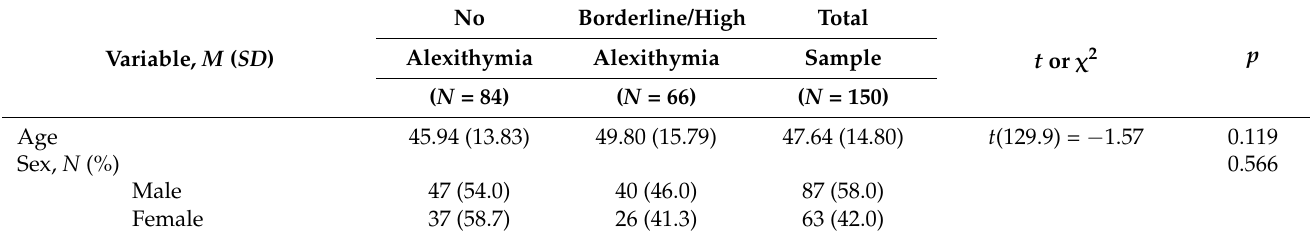
Table 1. Comparisons of socio-demographic and clinical features between alexithymic (positive or borderline positive) and non-alexithymic psoriasis